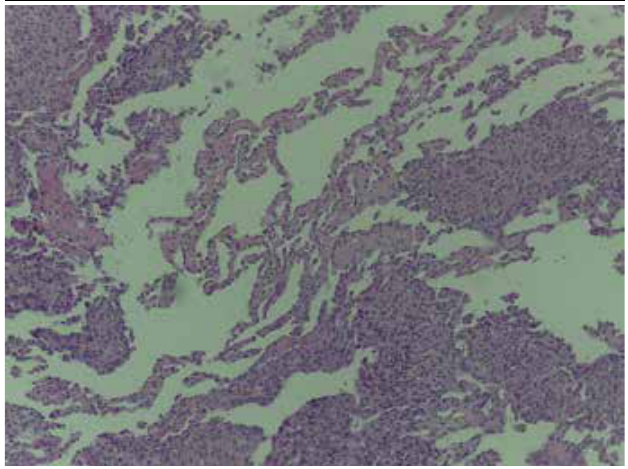
figuRE 3 − Proliferation of epithelioid cells forming vascular spaces of varying sizes, sometimes with papillary hyperplasia in the lumen (HE, 100×) HE: hematoxylin and